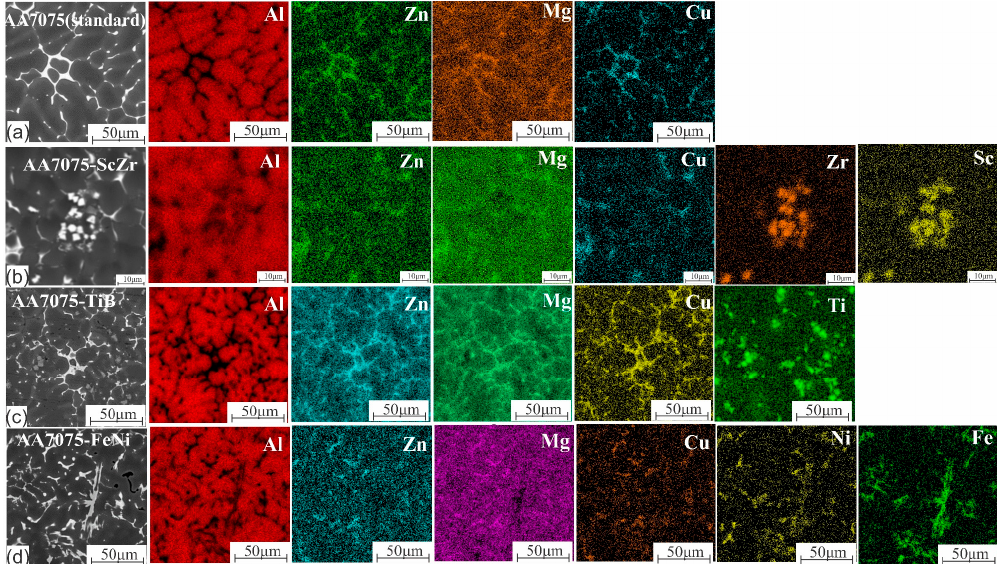
Figure 2. Maps of the elemental distributions of the investigated alloys in the as-cast state: ( a ) AA7075 standard, ( b ) AA7075-ScZr, ( c ) AA7075-TiB, ( d )AA7075-FeNi. standard, ( b ) AA7075-ScZr, ( c ) AA7075-TiB, ( d